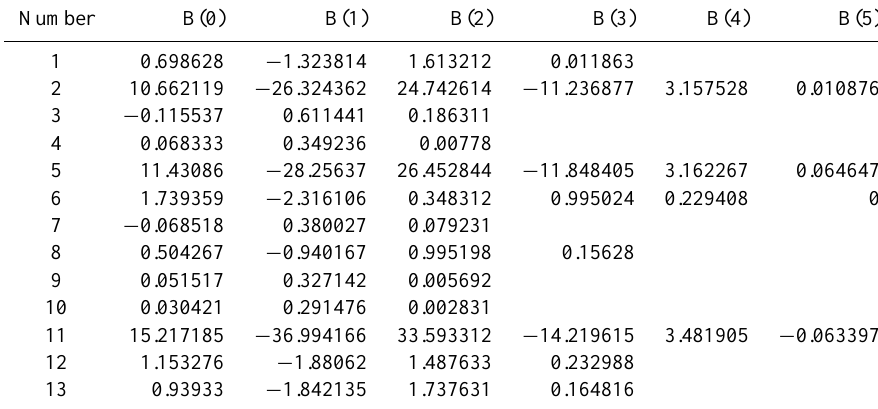
= B ( 0 ) ∗ ( RH / 100 ) order + B ( 1 ) ∗ ( RH / 100 ) order − 1 wi